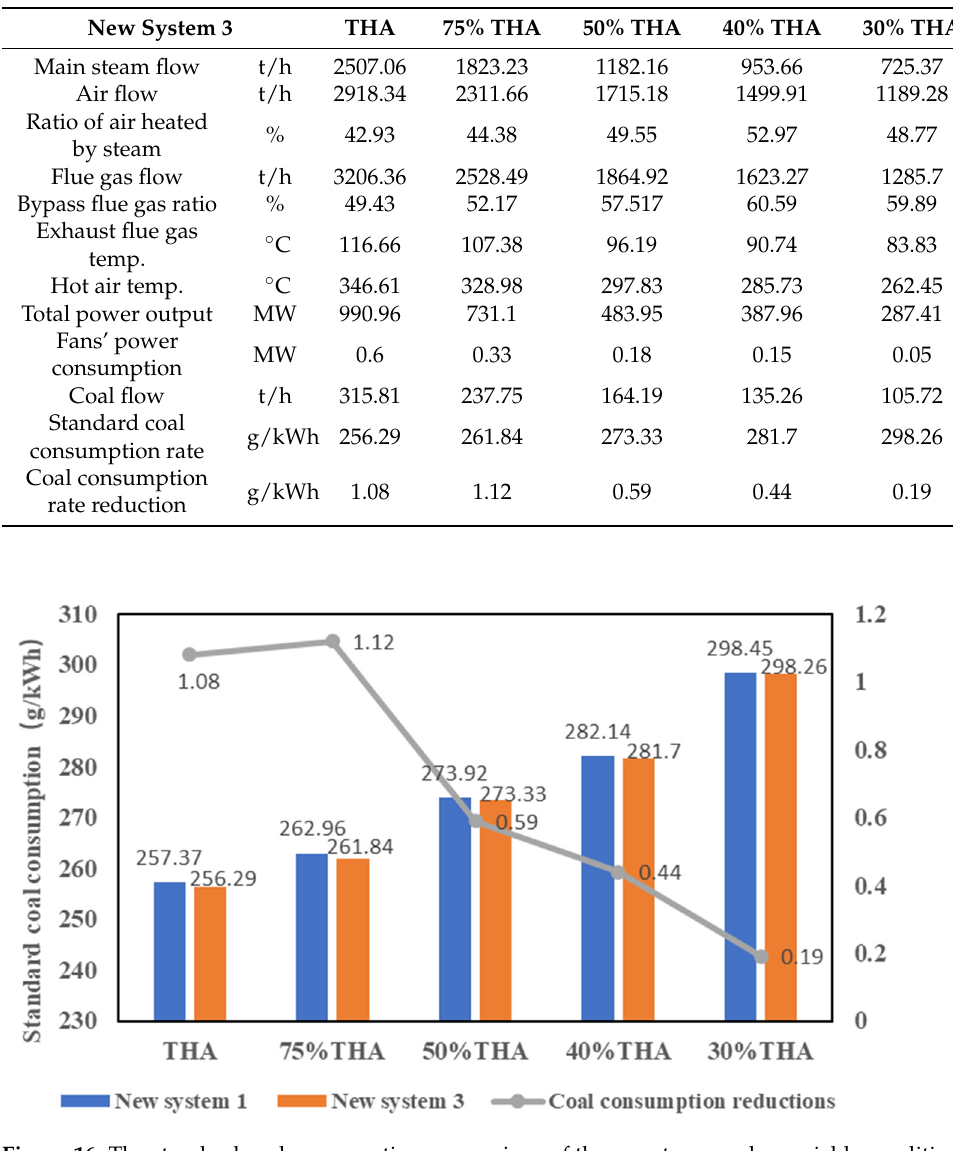
Table 5. Analysis of main parameters under variable parameters.